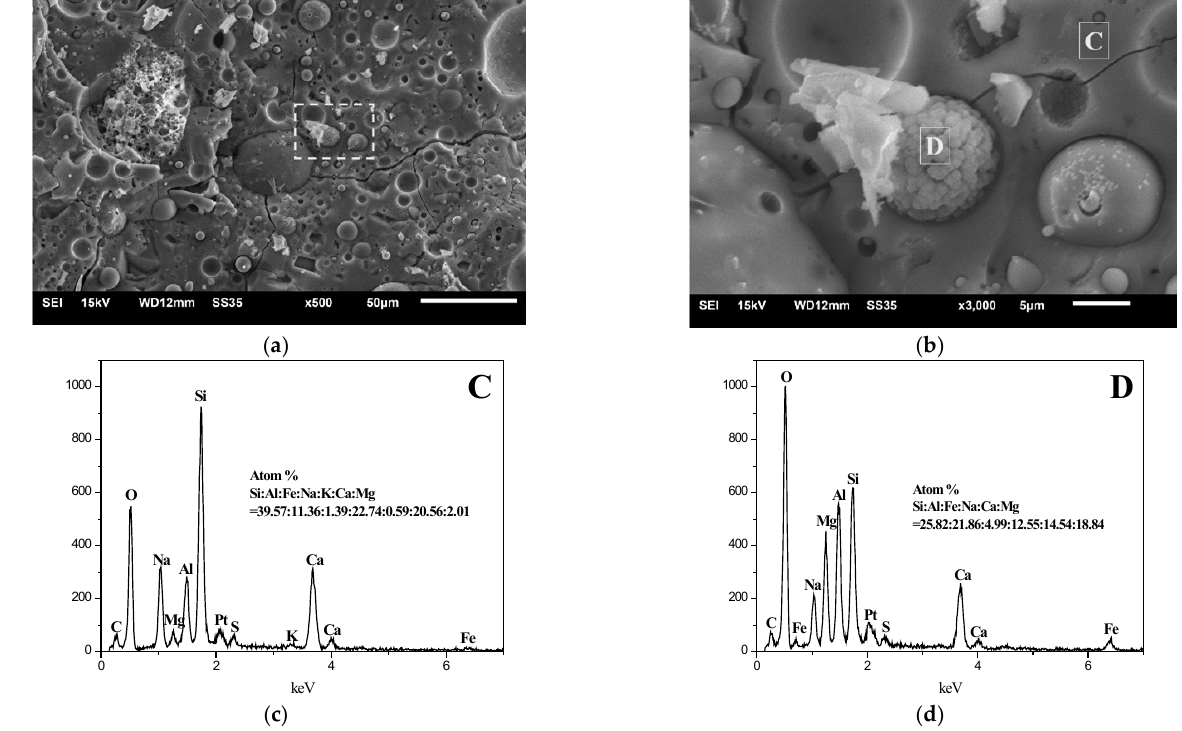
Figure 8. SEM–EDS patterns of G-9-12-30: ( a ) SEM image (×500); ( b ) SEM image (×3000); ( c ) elemental composition: Area C; ( d ) elemental composition: Area D.